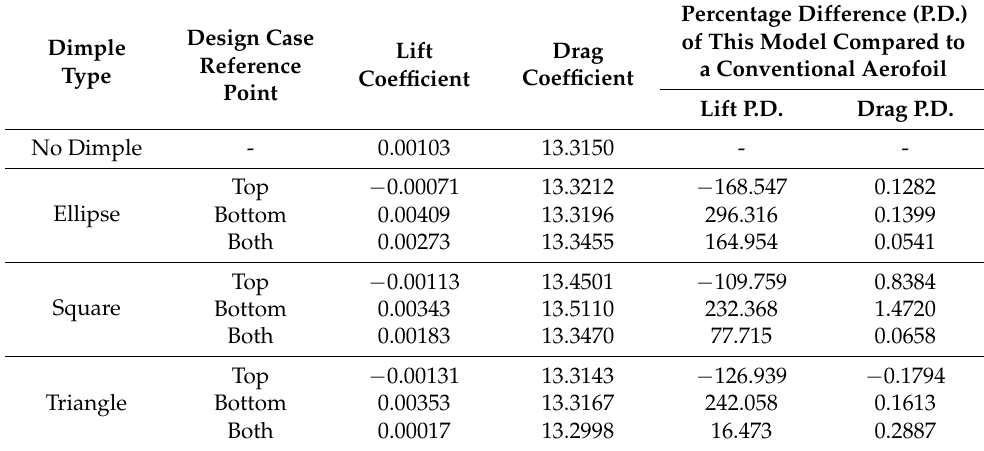
Figure 24. Dimple study boundary domain, showing ( a ) wall conditions, and ( b ) refined mesh model. Table 11. Results from the SimScale verification